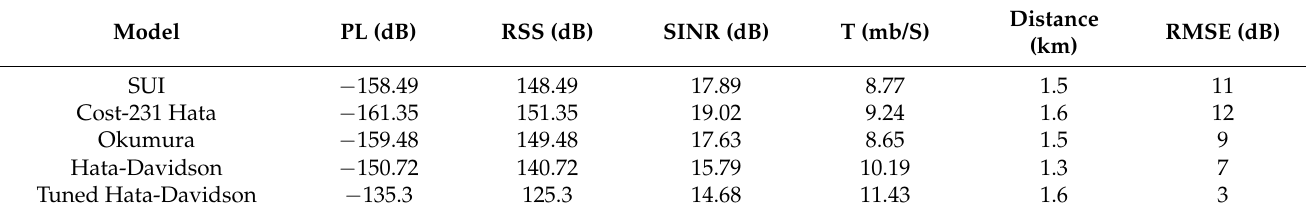
Table 4. Validation results of the modified Hata-Davidson model against other propagation